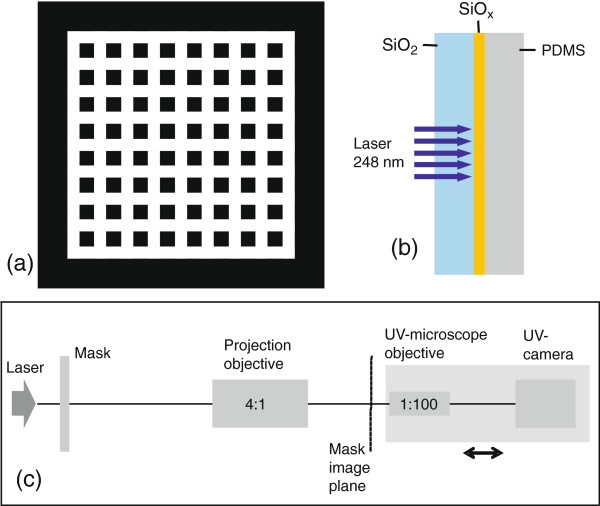
Experimental arrangement. Mask design with transparent stripes (white) (a), sample configuration for laser processing (b), and experimental arrangement for mask projection and for the measurement of the beam profile in the sample plane (=mask image plane) (c).